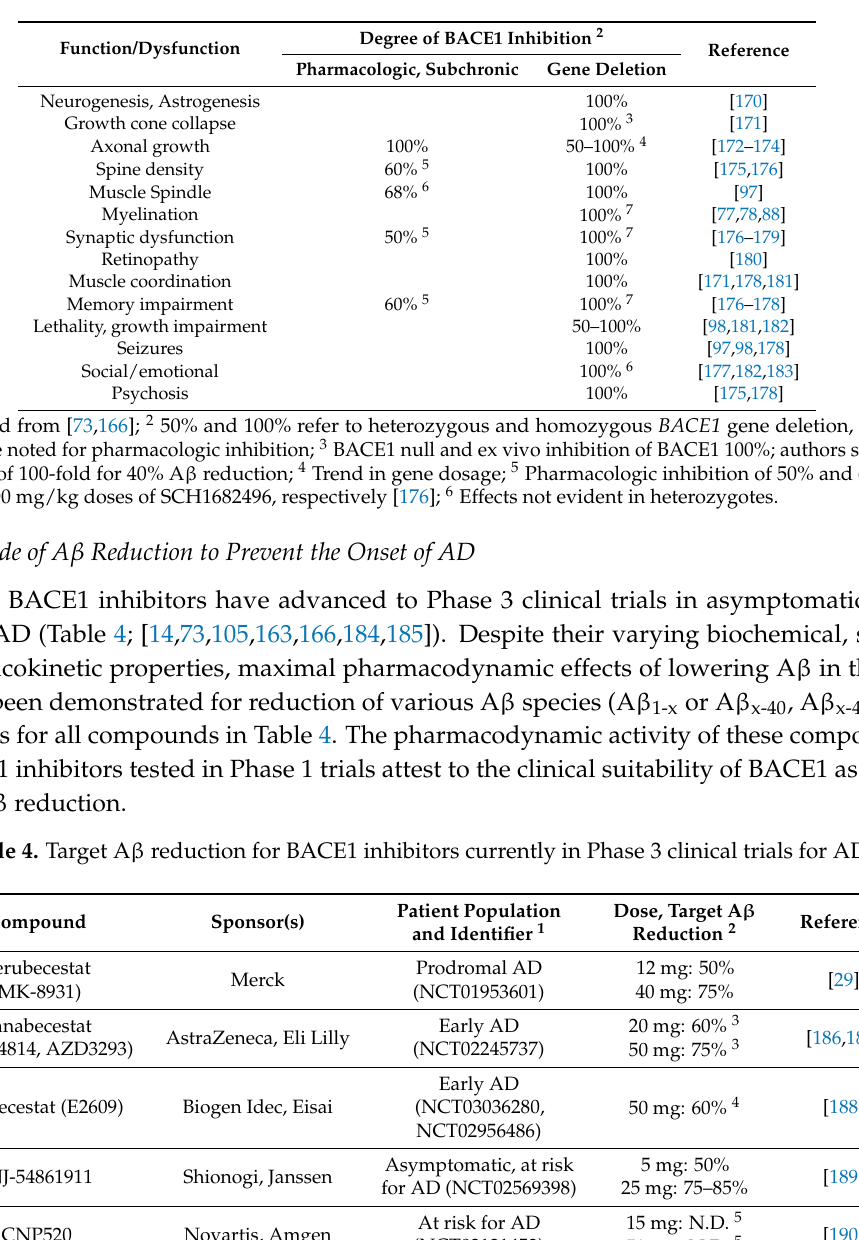
Table 3. Morphologic, physiologic and behavioral impact of BACE1 depletion 1 .